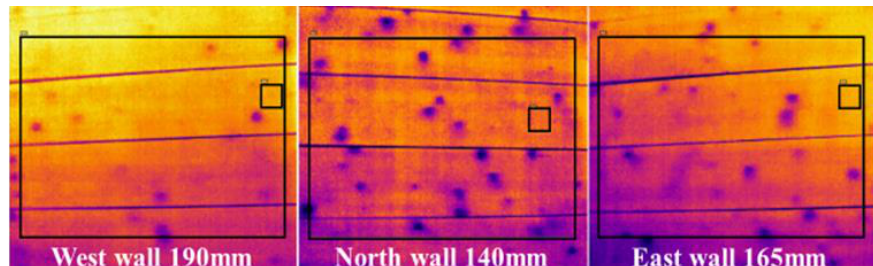
Figure 3. Representative example of thermal images of the three walls taken 1st of February. The indoor and outdoor temperatures at the time were 21.2 °C and −7 .5 °C, respectively. The temperature scale in each image ranges from 15 °C to 19 °C. The darker areas represent colder surface temperatures. Table 2. Temperature statistics obtained from the thermal images in Figure 3.